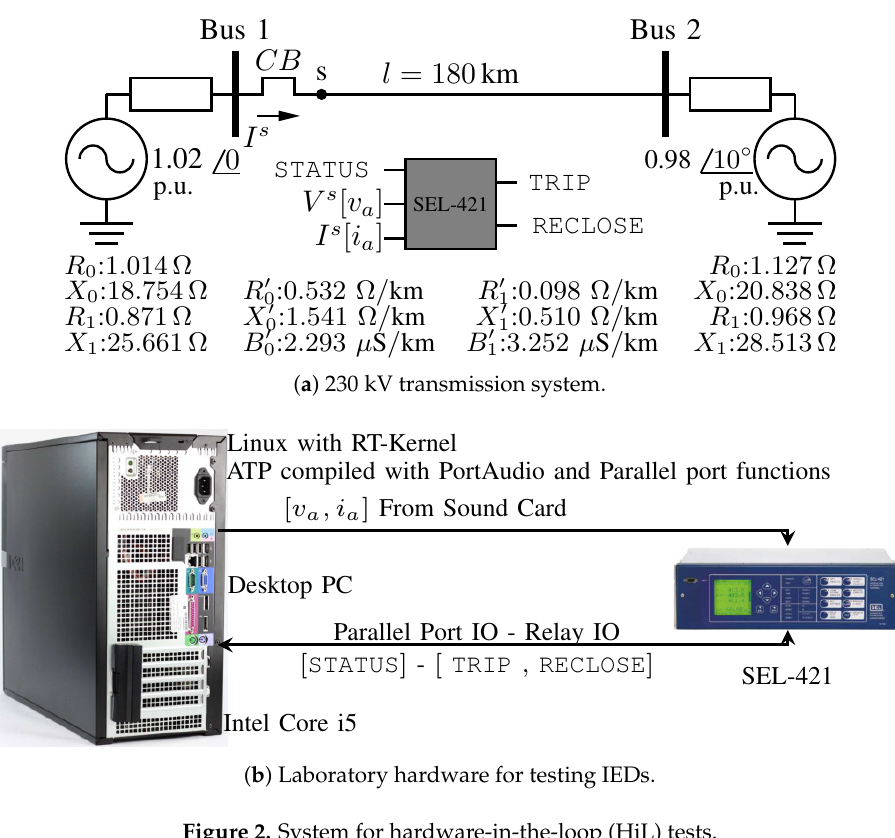
Figure 2. System for hardware-in-the-loop (HiL)